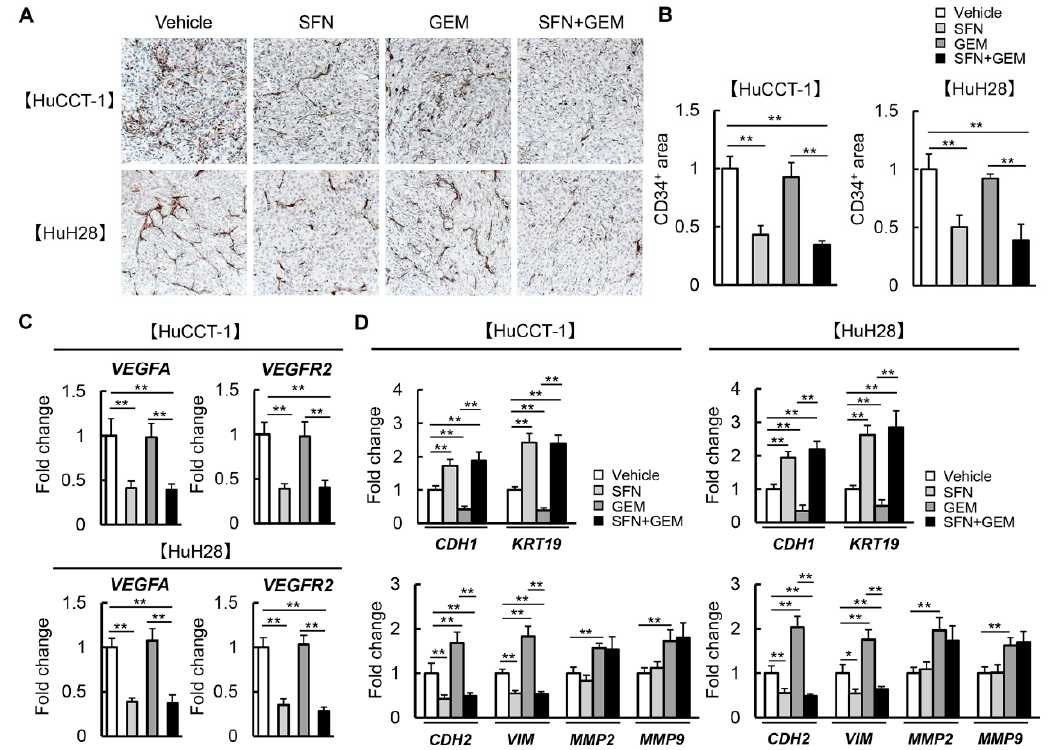
Figure 7. Intratumor angiogenesis and EMT in iCCA-derived xenograft tumors by treatment with SFN and GEM. ( A ) Representative images of CD34 + neovascularization in the HuCCT-1 and HuH28-grafted tumors. Scale bar; 100 μ m. ( B ) Semi-quantitation of CD34 + vessels in the high-power field (HPF) by ImageJ software. Quantitative analysis included 10 fields per section. ( C , D ) Relative mRNA expression of pro-angiogenic VEGFA and VEGFR2 ( C ) and epithelial CDH1 and KRT19/mesenchymal CDH2, VIM, MMP2 and MMP9 ( D ) in the HuCCT-1 and HuH28-grafted subcutaneous tumors. GAPDH was used as an internal control for qRT-PCR. The values are shown as fold changes relative to the vehicle group ( B – D ). Data are mean ± SD ( n = 20 tumors/10 mice). * p < 0.05; ** p < 0.01 indicating a significant difference between groups.